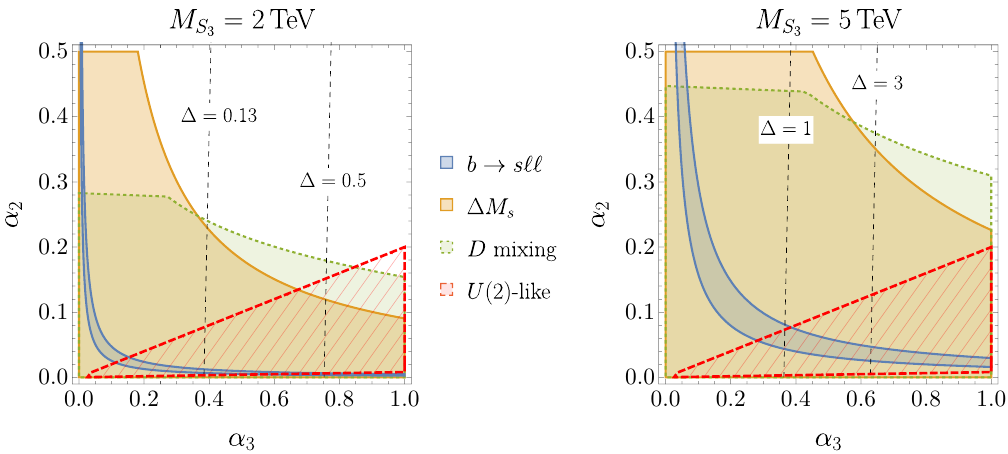
Figure 3 . Constraints on the leptoquark couplings to sµ ( α 2 ) and bµ ( α 3 ), for fixed leptoquark masses of 2 TeV (left) and 5 TeV (right), both of which are above the mass range excluded by LHC direct searches. In addition to the 2 σ contours from a global fit to the b → s‘‘ data (blue), from B s mixing constraints (orange), and from D mixing constraints (green, dotted), we plot contours from finite naturalness of the Higgs mass, in this case coming from eq. (3.6). Finally, the red hatched regions are compatible with a U(2) -like flavour structure, for which α 2 /α 3 ∈ [0 . 2 , 5] V ts . From the left plot, we see that a lighter mass leptoquark requires significantly less Higgs-mass tuning; the contour with ∆ = 0 . 13 indicates comparable tuning to that in the SM. For the 5 TeV leptoquark, we see that a U(2) -like structure can only accommodate the 2 σ fit to the B -anomalies with ∆ & 1 , meaning the finite loop correction to the Higgs mass is greater than 125